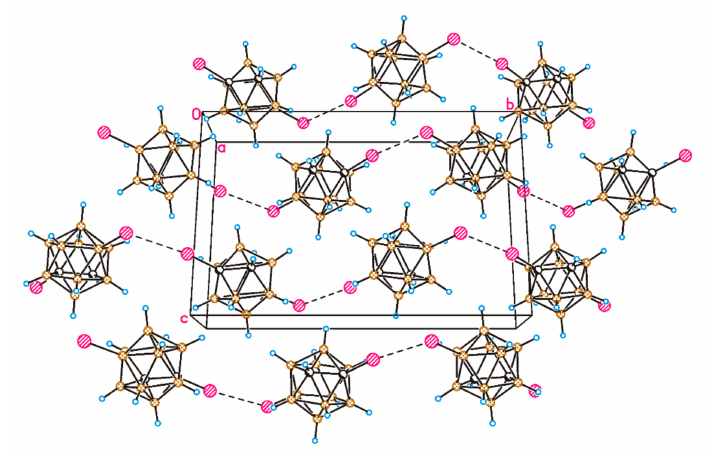
Figure 2. Crystal packing fragment of 1,12-I 2 -1,2-C 2 B 10 H 10 . Halogen bonded chains are formed along axis b .